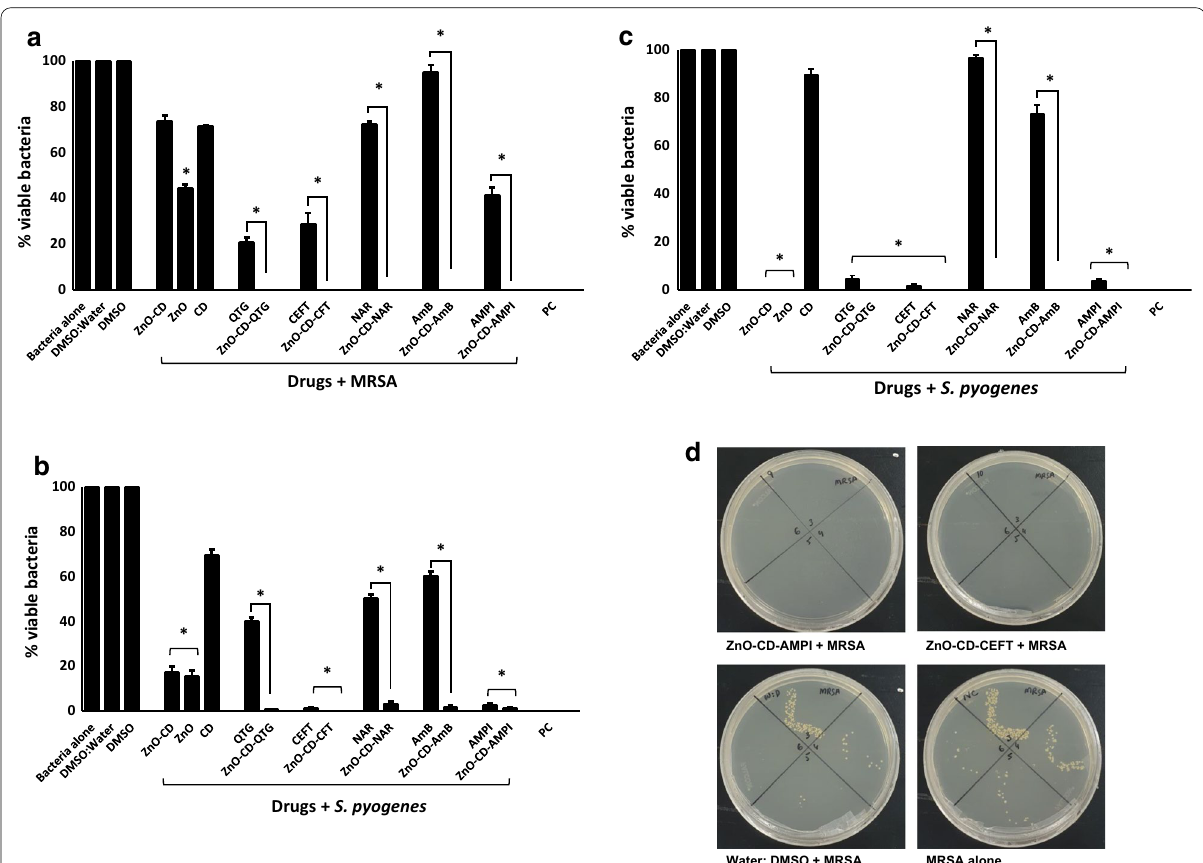
Fig. 6 ZnO-NPs loaded with various drugs showed important antibacterial activity against Gram-positive pathogenic bacteria. Briefly, bacteria (1 10 6 ) were incubated with different drugs conjugated with ZnO-NPs and nanoparticles alone for two hours at 37 °C as defined in Materials and × Methods. Next, the cultures were ten-fold serially diluted and plated onto the nutrient agar plates. The plates were incubated for 24 h at 37 °C and enumerated the viable bacterial colonies on the next day. The results showed that drugs conjugated ZnO-NPs exhibited significant antibacterial activity against the Gram-positive bacteria. For negative control, bacteria were incubated in PBS alone whereas for positive control gentamicin (100 µg/mL) was used. The data are representative of several experiments performed in duplicate and expressed as the mean where (*) represent when P ≤